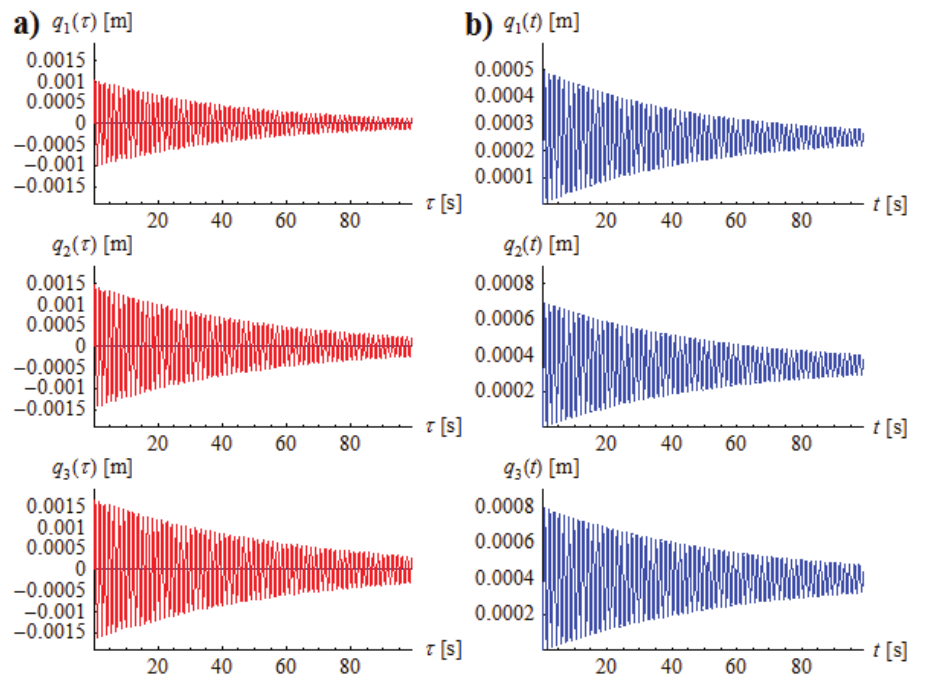
Figure 5: The results obtained from the first measurement: (a) displacement plots in the time domain t and (b) displacements determined in accordance with formula (7).